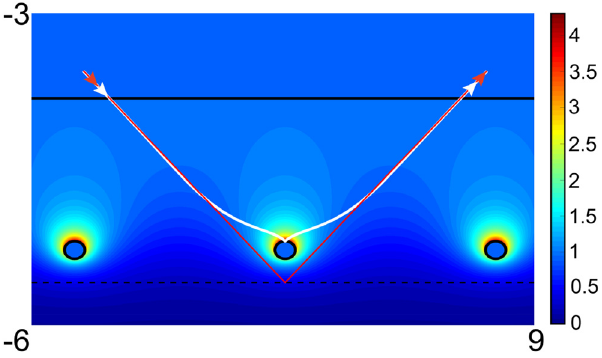
fects are chosen as y = 0.08, w = 0.08, d = 3.25 and 0 0 y = 0.08, w = 0.08, d = 4, respectively. As comparison, the 0 0